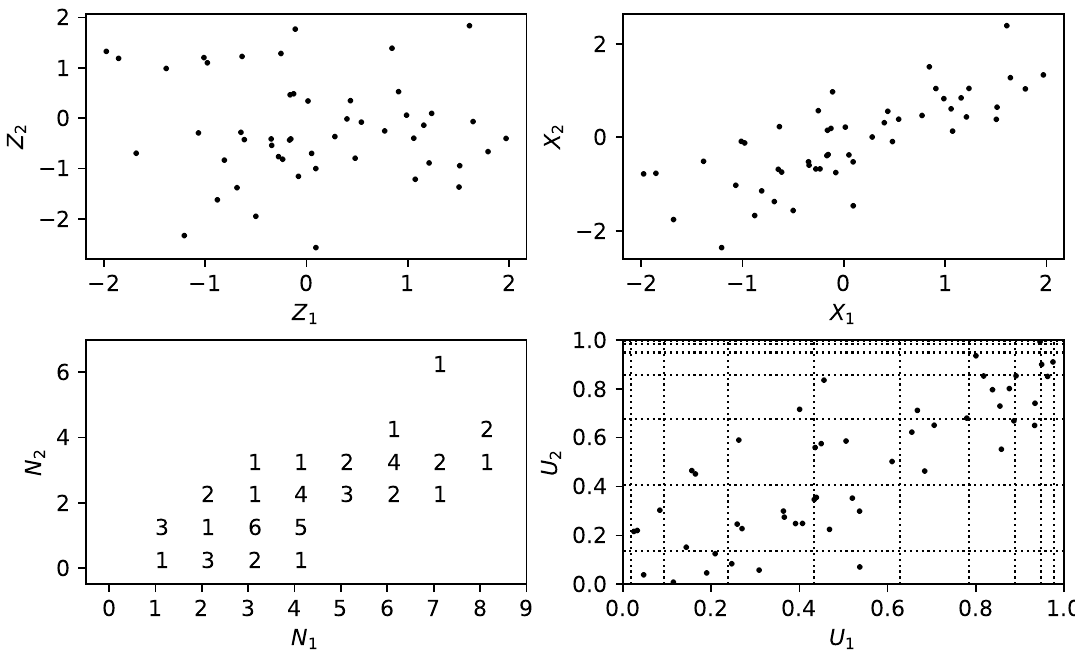
Figure 1. Moving clockwise from the top left, the four plots show how to simulate 100 pairs ( N 1 , N 2 ) of Poisson random variables with λ 1 = 4.0, λ 2 = 2.0 under a Gaussian copula with ρ = 0.8. The top left hand plot shows 100 pairs of independent N ( 0,1 ) random variables ( Z 1 , Z 2 ) . In the top right hand plot these are mapped to correlated standard normal random variables ( X 1 , X 2 ) using the Cholesky decomposition of the covariance/correlation matrix. In the bottom right hand plot, these are mapped backwards to [ 0,1 ] 2 using the standard normal CDF to give correlated uniform random variables ( U ) . The dashed lines are from the PMF of the two Poisson random variables, which can be used in 1 , U 2 inverting the joint distribution. The final picture shows the simulated distribution; that is, the number of simulated outcomes of each pairing of N 1 and N 2 . As an example, because there are six points ( U ) that are in [ F ( 2 ) , F ( 3 )] × [ F ( 0 ) , F ( 1 )] there are six outcomes of { N = 3, N = 1 } N 1 N 1 N 2 N 2 2 1 , U 2 1